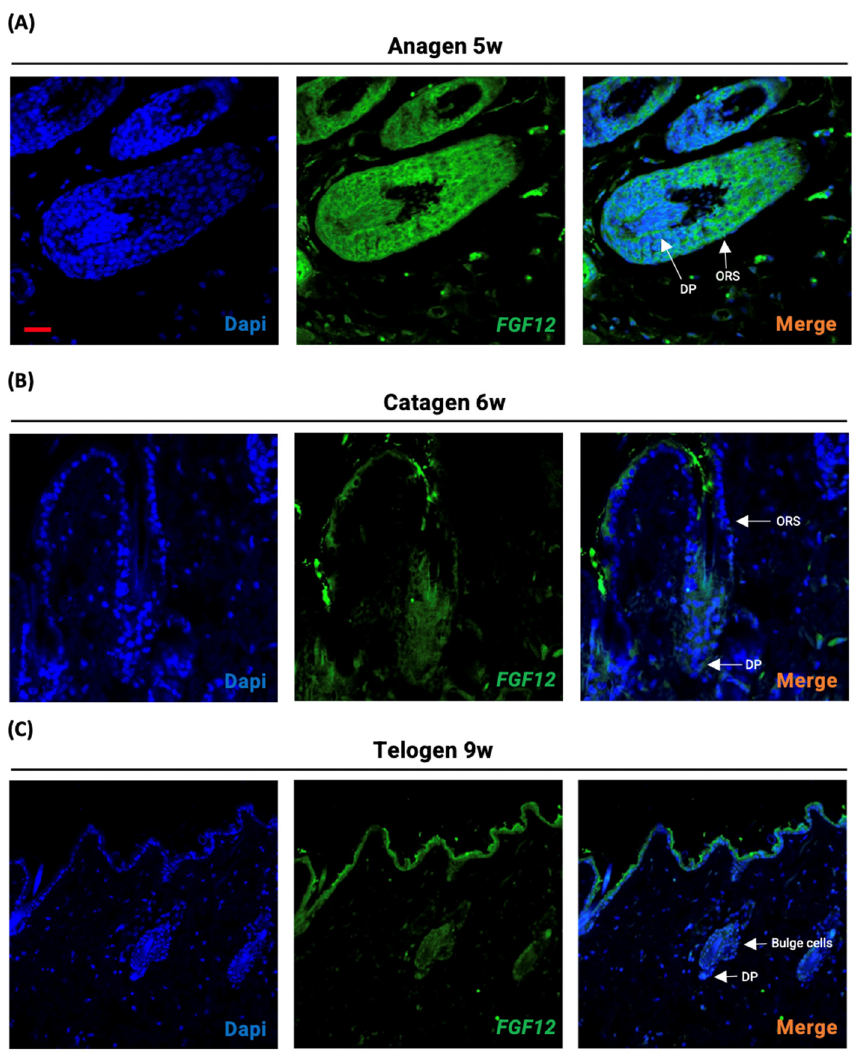
Figure 1. Localization of FGF12 during the hair growth cycle. ( A – C ) Immunofluorescence images show expression of FGF12 protein in hair follicles of C3H/HeN mouse. Longitudinal sections of dorsal skins stained with anti-FGF12 antibody (Green) and Dapi (Blue) during anagen at 5-week ( A ), catagen at 6-week ( B ), and telogen at 9-week ( C ) phases. scale bar = 50 μ m.